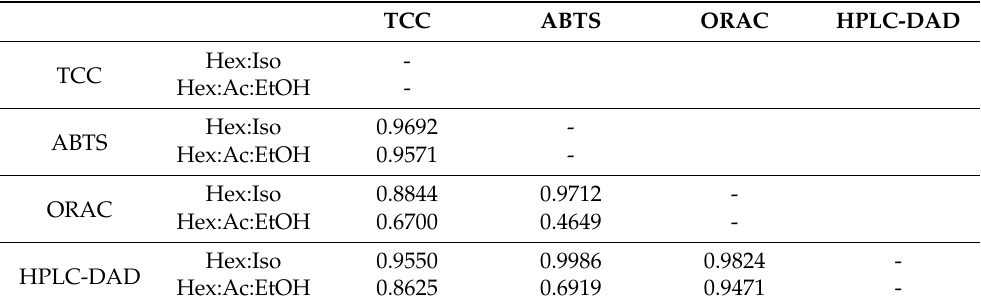
Table 5. Correlation between all analytical parameters (TCC, ABTS, ORAC, and HPLC-DAD) used